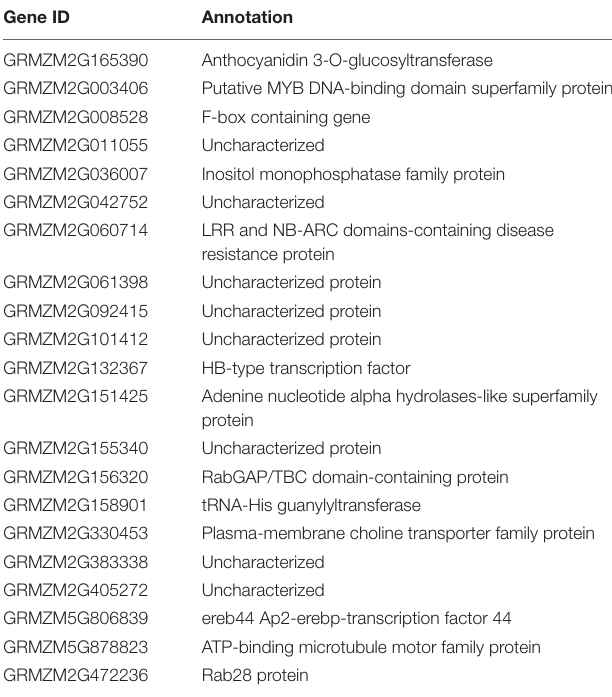
TABLE 1 | Predicted downstream targets of the ZmPRms gene in